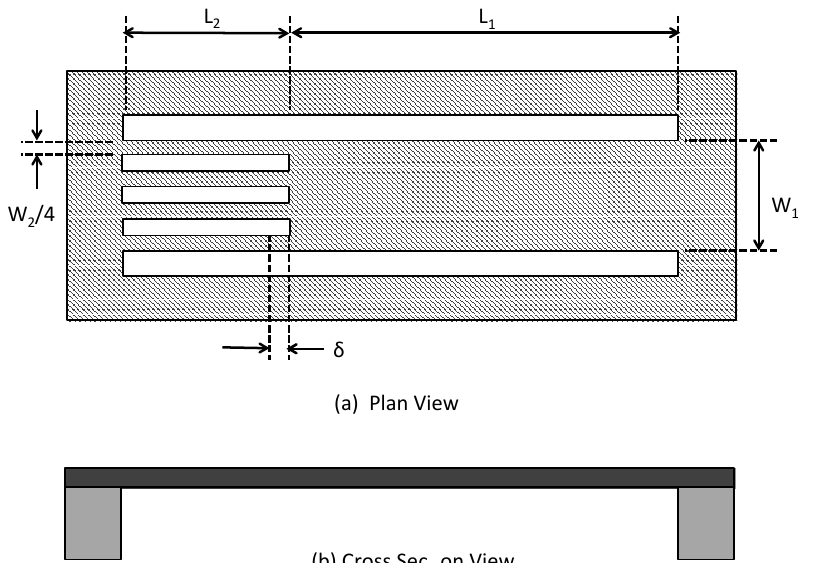
Figure 11. Illustration of the H-structure for measuring residual stress in thin-film layers.